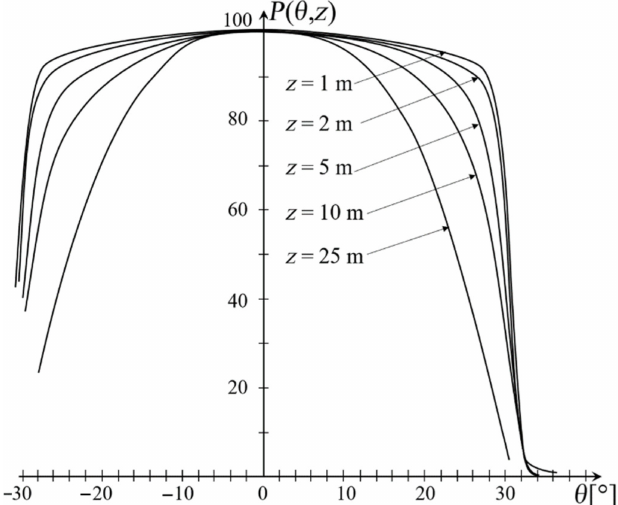
Figure 2. Measured normalized P ( θ , z ) at different lengths of the CROFON fiber, in the case of central launch ( θ 0 = 0 ◦ )